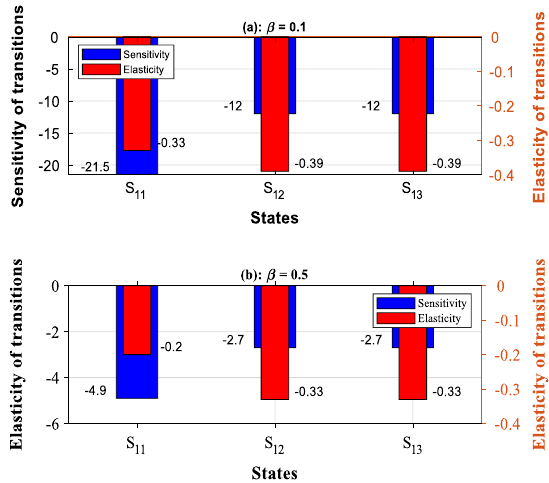
Fig. 18 Sensitivity and elasticity of system to CCF—Medium diagnostic coverage